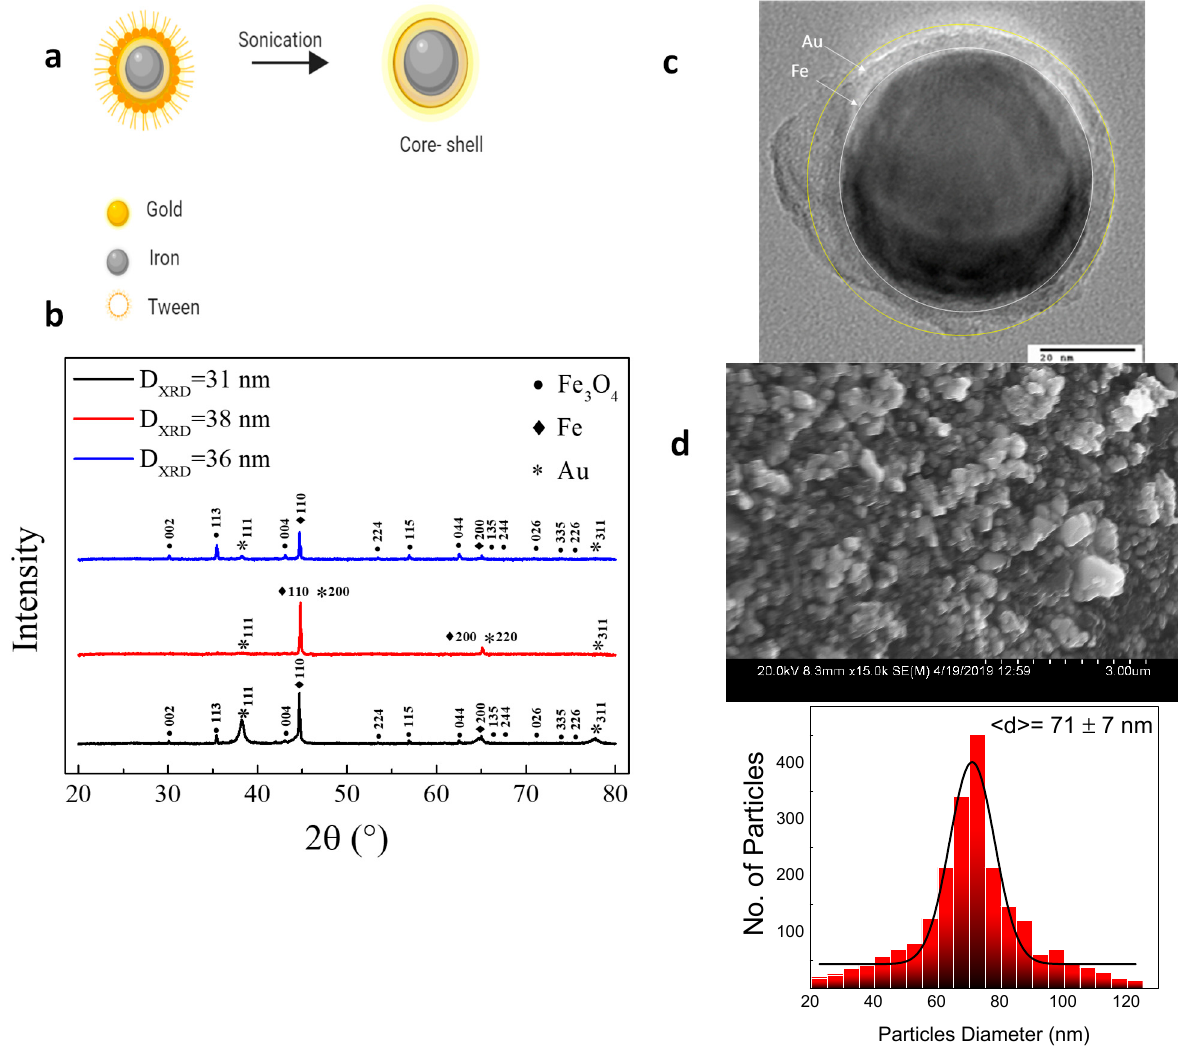
Figure 1. ( a ) The schematic diagram represents Fe/Au core/shell synthesis, ( b ) XRD patterns of Fe/Au core-shell nanopar- ticles with different metal ratios 1:1, 2:1, and 3:2; ( c ) HR-TEM of the Fe/Au core-shell assembly; ( d ) size distribution of the as-prepared Fe/Au core-shell nanoparticles.